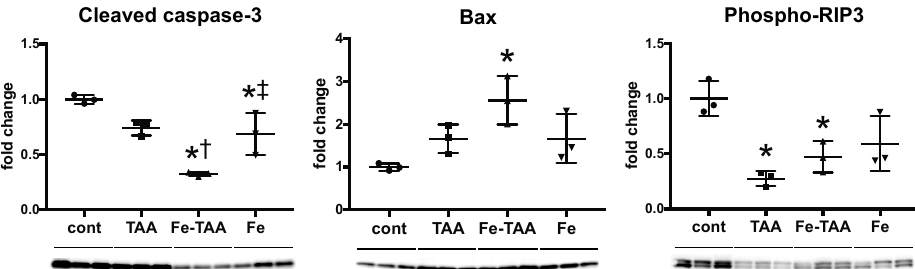
Figure 7. Western blot data for cleaved caspase-3 (apoptosis marker), Bax (mitochondrial pro-apoptotic protein) and phospho-RIP3 (necroptosis marker) using liver samples at week 6. Data are normalized by α -tubulin for cleaved caspase-3 and phospho-RIP3 and by porin (anti-porin/voltage-dependent anion-selective channel protein 1, VDAC1) for Bax, and expressed as mean ± SD. * p < 0.05 vs. cont.;